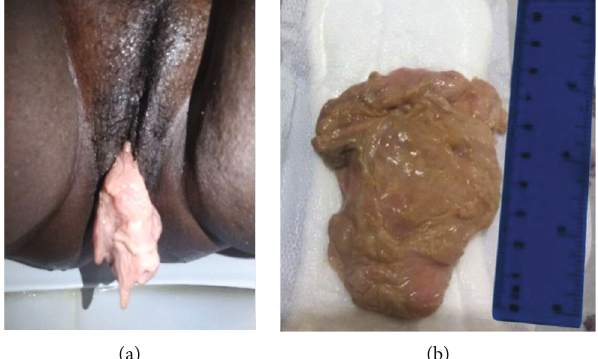
Figure 3: (a) Vaginal expulsion of infarcted submucous fi broid 15 days after uterine artery embolization. (b) Specimen measuring approximately